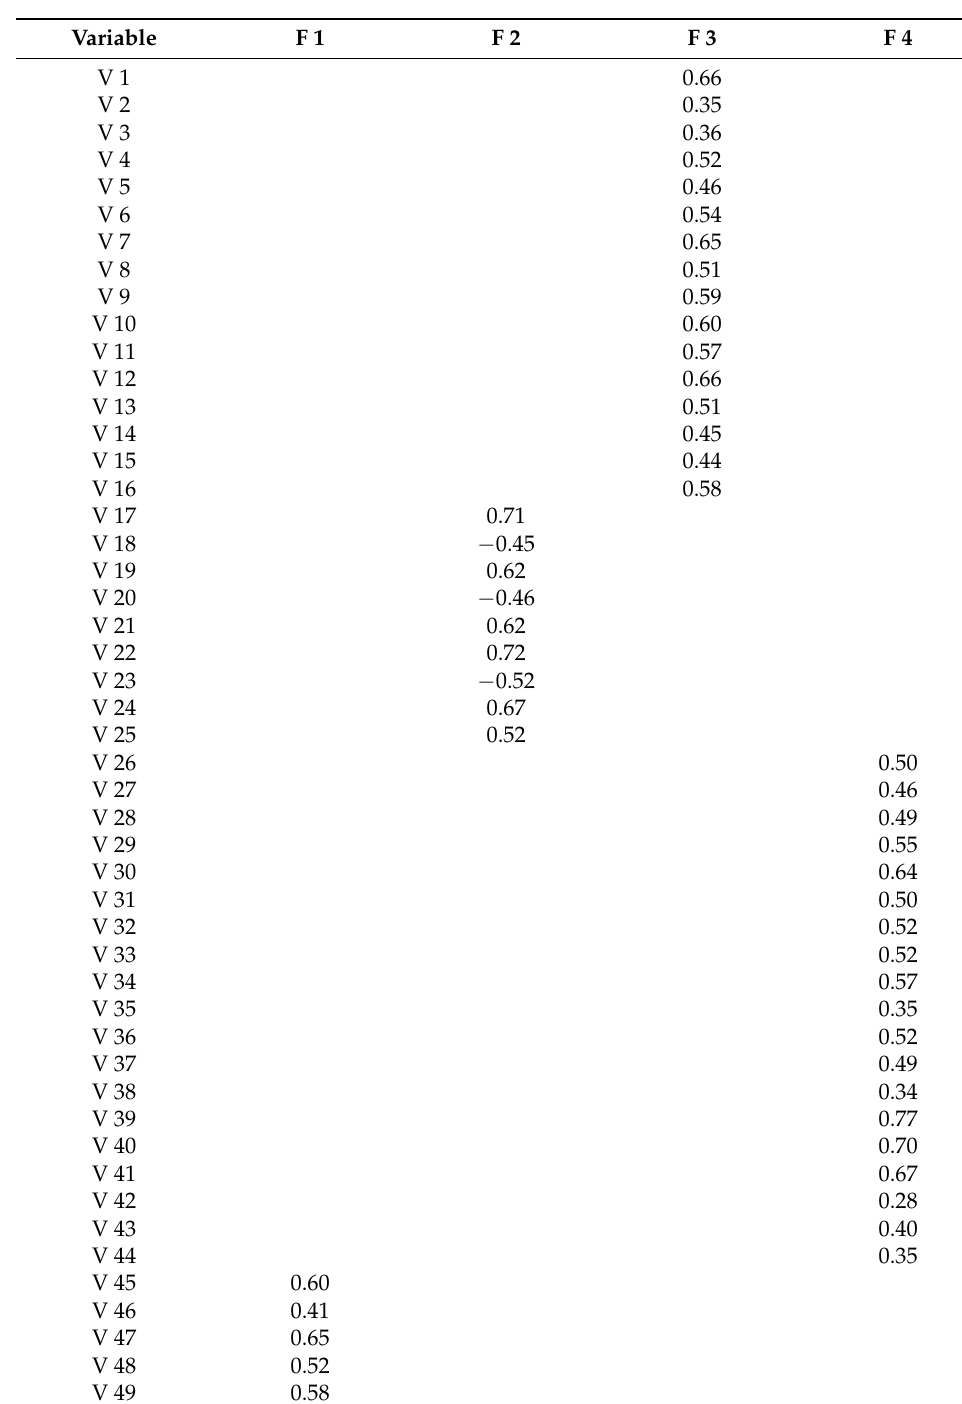
Table 1. Matrix of rotated